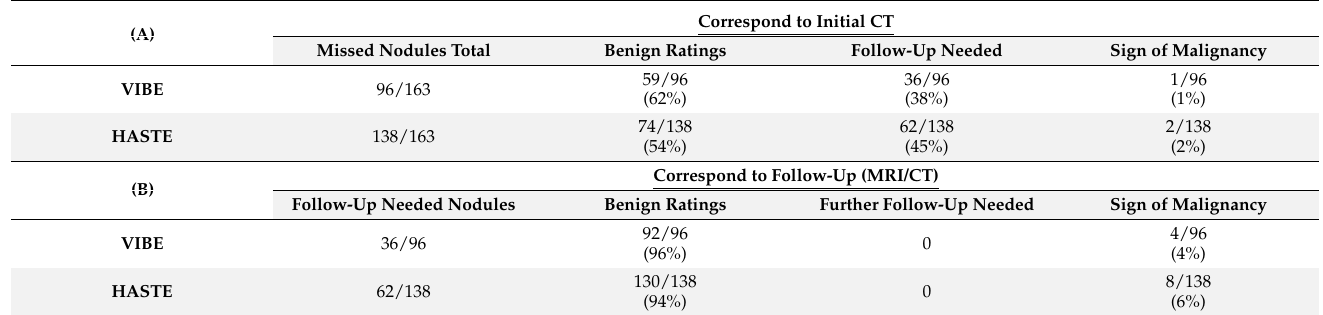
Table 2. Lesion-based analysis. ( A ) Classification of lung nodules at MRI VIBE or MRI based on initial CT. ( B ) Classification of lung nodules at MRI VIBE or MRI HASTE based on initial CT that needed further follow-up